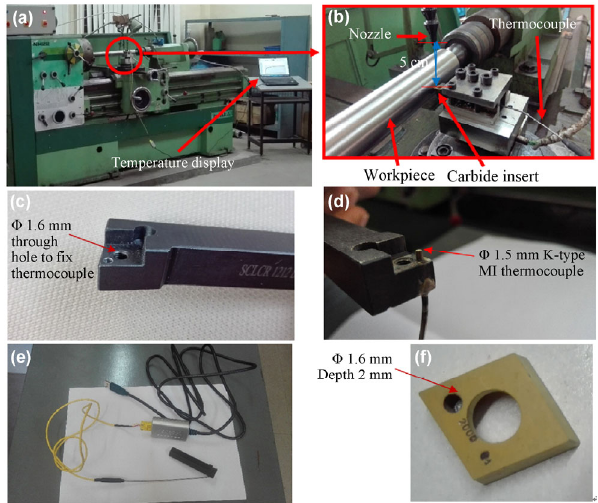
Fig. 4 (a) Turning experimental setup; (b) machining zone close view; (c) tool holder with drilled hole; (d) tool holder fitted with thermocouple; (e) USB TC-01 NI DAQ system; (f) carbide tool insert with drilled